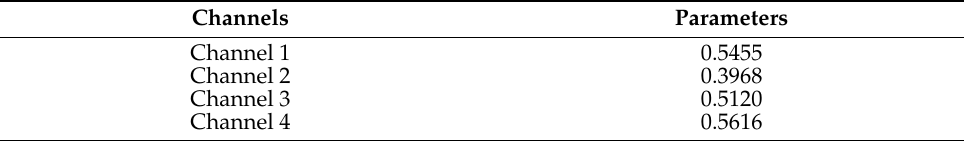
Figure 12. Loss parameters. Table 10 is an explanation of data loss on each channel. Table 10. Loss parameters.